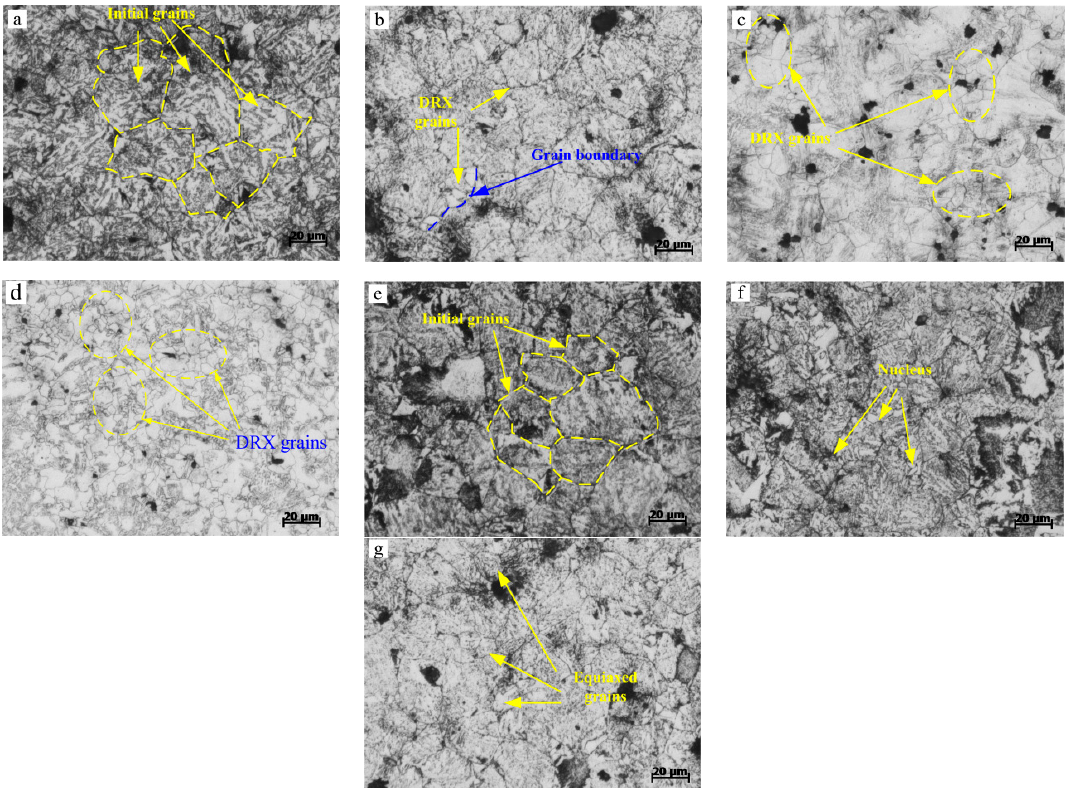
Figure 9. Surface microstructure of 42CrMo steel under different pre-stresses and grinding depths.